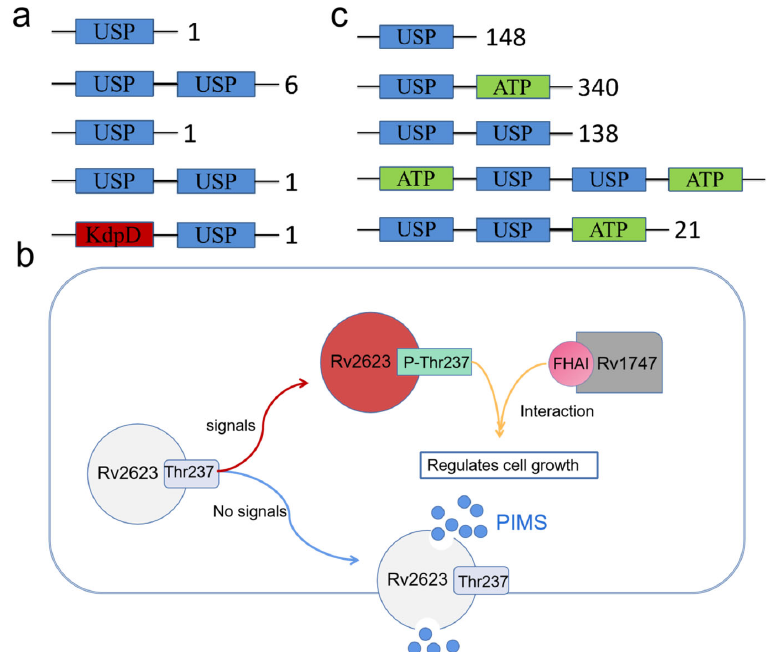
Figure 3. Classification of M. tuberculosis , Vibrio desulfuricans and interaction of Rv2623 with Rv1747. ( a ) There are ten USPs of Mycobacterium nucleatum, which are classified into five categories. ( b ) Rv2623 regulates M. tuberculosis growth. When certain signals are present, Rv2623f Thr237 is